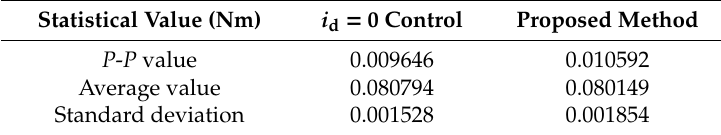
Figure 14. Electromagnetic torque of proposed method. Table 2. Statistics of evaluated torque.